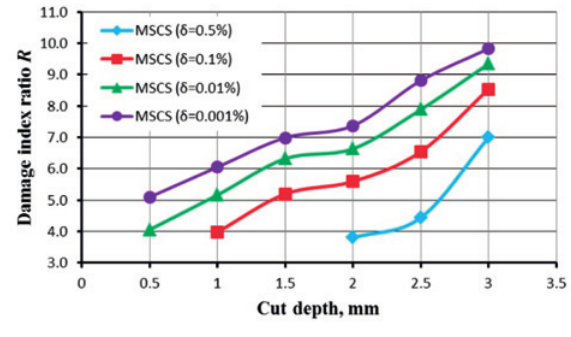
fig. 3. Damage index ratios for the MSCS damage index